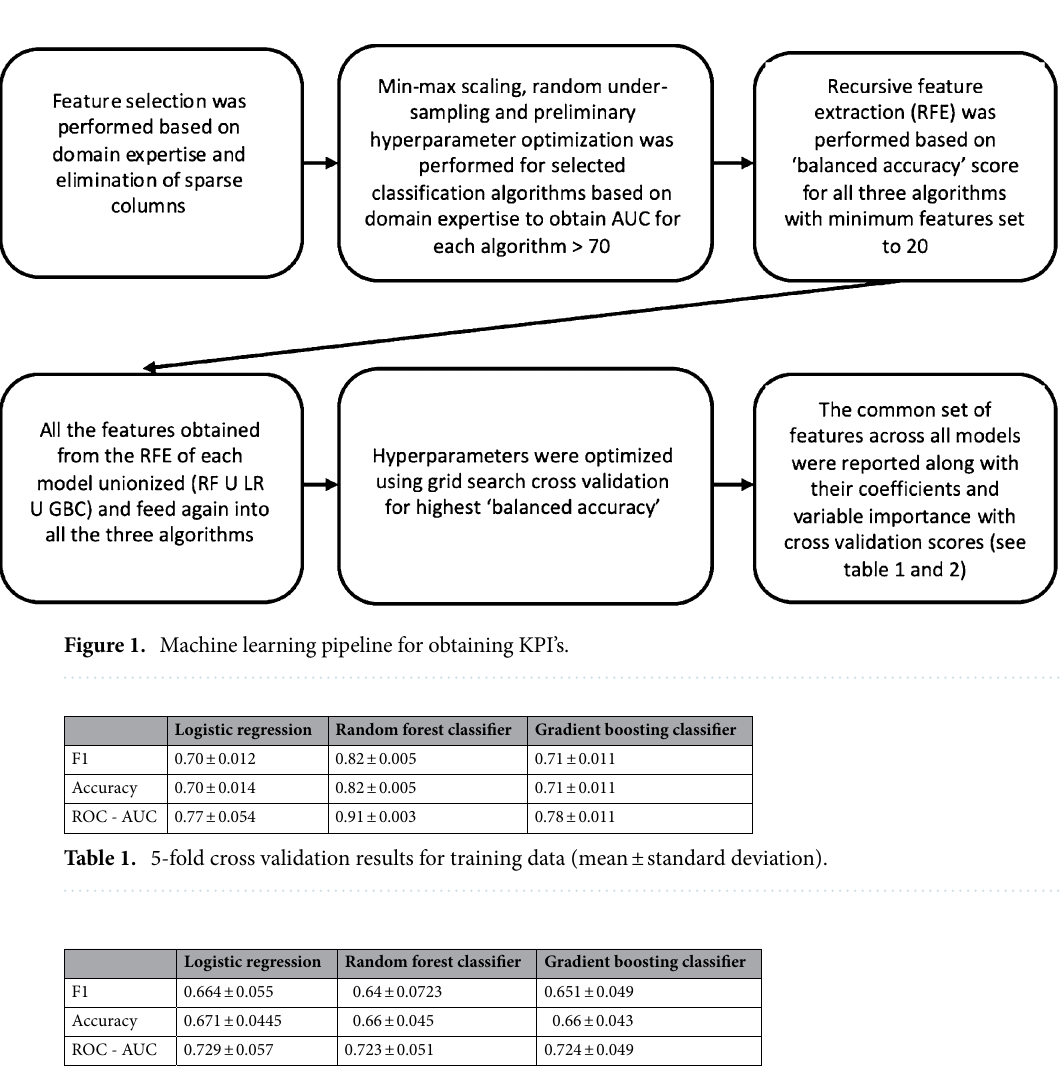
Table 2. 5-fold cross validation results for testing data set (mean ± standard